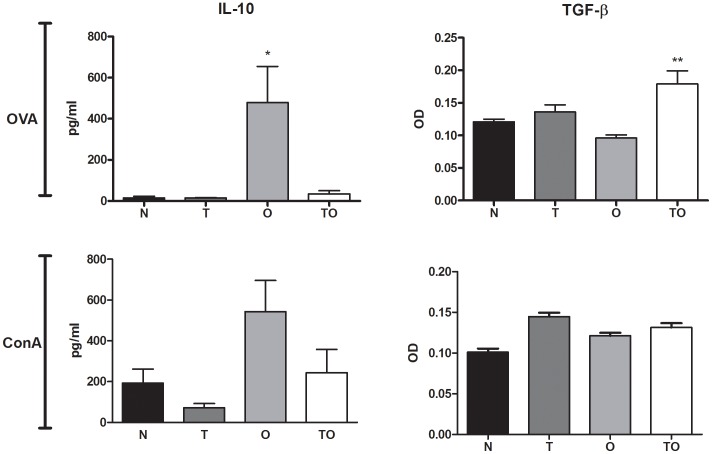
Production of local regulatory cytokines.Cytokine production by thoracic lymph node cells cultured with OVA or ConA in vitro were measured in mice OVA-sensitized (O), T. gondii infected/OVA sensitized (TO) (both groups aerosolized with OVA), T. gondii infected (T) or naïve (N) mice (both negative groups aerosolized with PBS).*p<0.05 O vs all other groups, **p<0.05 TO vs all other groups; ANOVA with Bonferroni a posteriori.